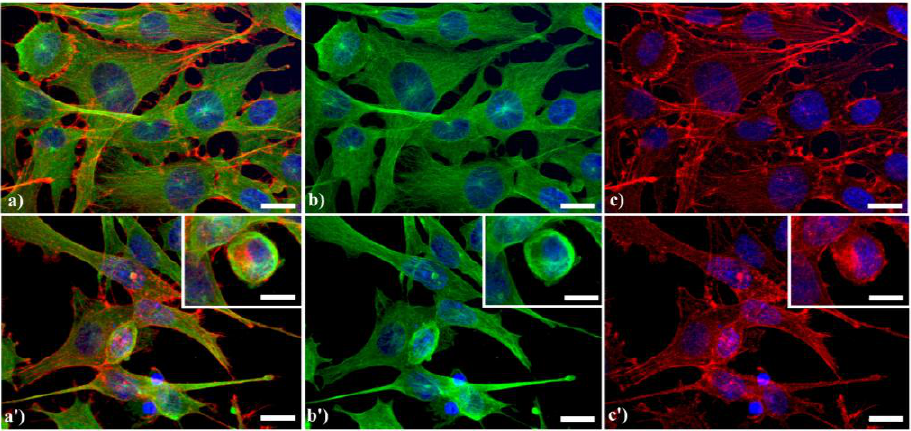
Figure 1. Fluorescence microscopy after double immunocytochemical detection of cytoskeletal components in B50 neuroblastoma cells. ( a – c ) control cells; ( a' – c' ) cells treated with 40 μM cysPt for 48 h. Cells on coverslips were fixed and processed for microfilaments (actin), labeled with Alexa 594-conjugated phalloidin (1:40 in phosphate buffered saline (PBS), red fluorescence; Molecular Probes, Invitrogen); microtubules were labeled with monoclonal anti-tubulin antibody (1:200 in PBS) revealed with Alexa 488-conjugated anti-mouse antibody (1:200 in PBS, green fluorescence; Molecular Probes). Cells were counterstained for DNA with 0.1 μg/mL Hoechst 33258 (blue fluorescence), washed with PBS and then mounted in Mowiol (Calbiochem) for microscopy analysis. Scale bar: 20 μm. Inset represents a late apoptotic